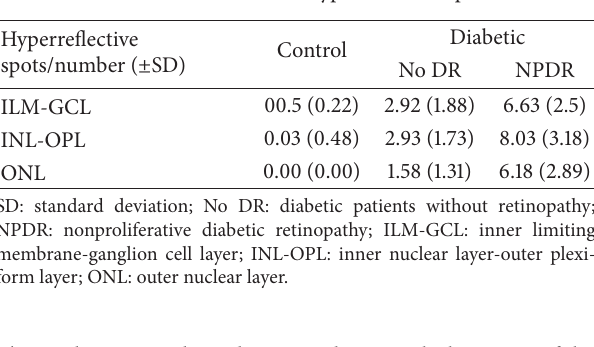
Table 2: The number of hyperreflective